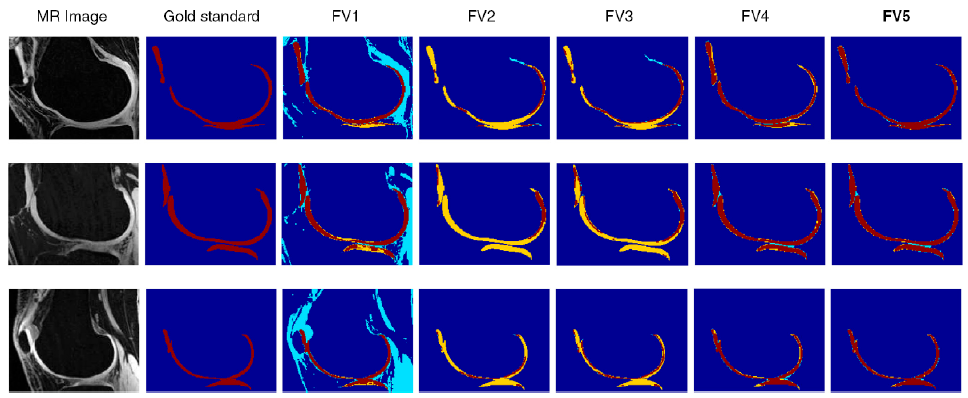
Figure 8. Segmentation findings for MR images using the hybrid SVM-DRF model with five types of feature vectors